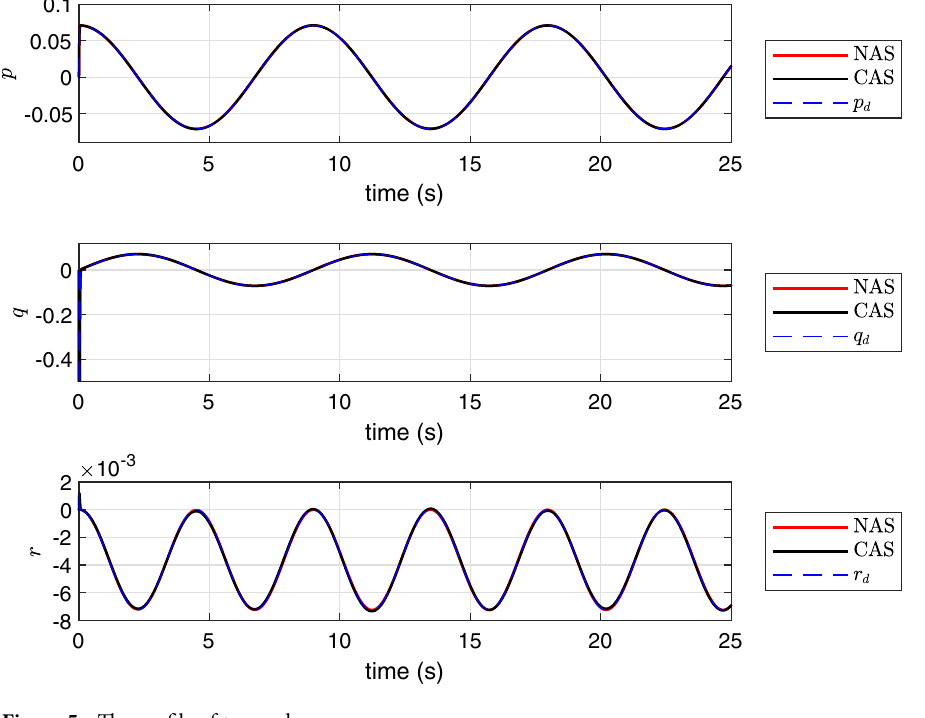
Figure 5. The profile of p , q and r